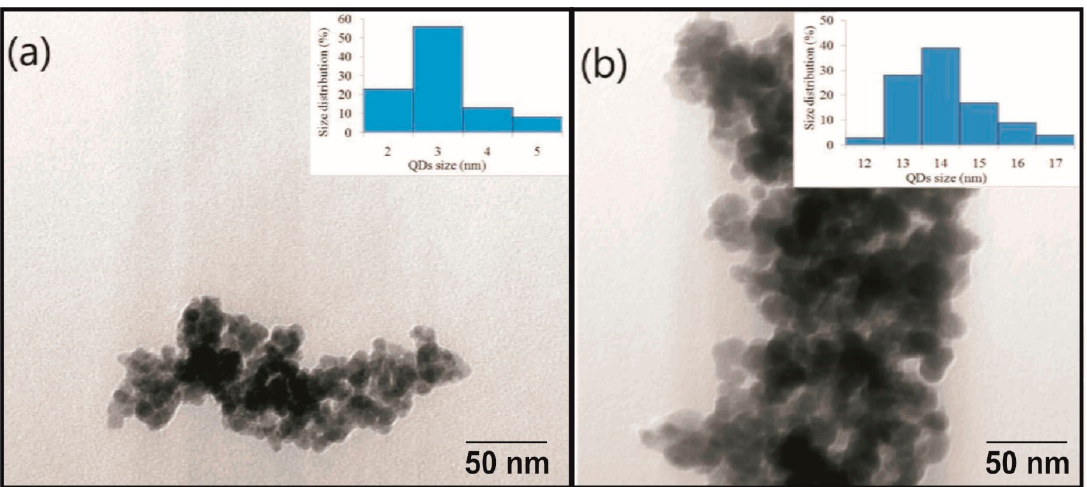
Figure 2. HRTEM image of Mn-doped CdSe QDs with the QD size distribution (inset) at ( a ) 0 and ( b ) 90 min reaction time.